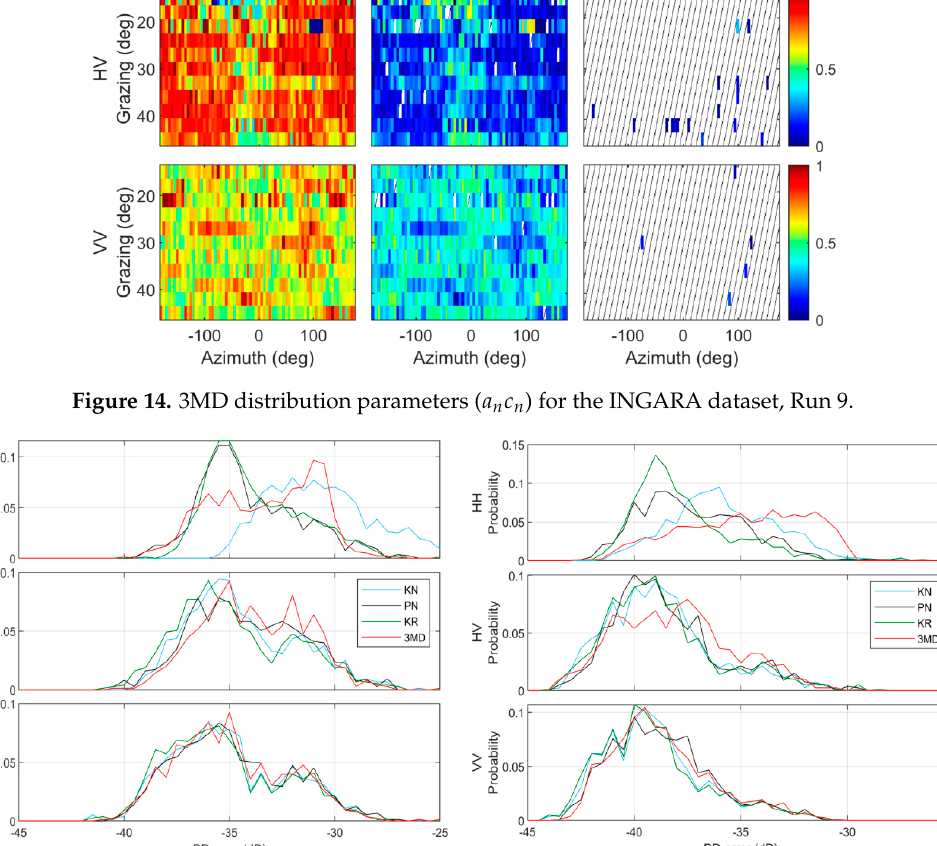
Figure 15. BD histograms for INGARA Runs 3 and 9. ( a ) Run 3, ( b ) Run 9.